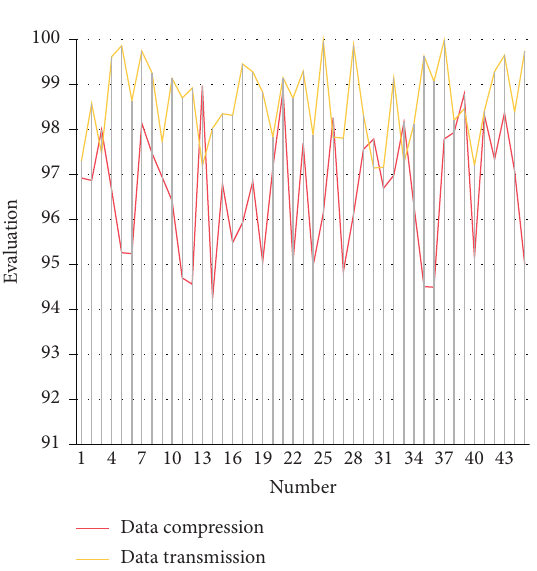
Figure 12: Statistical diagram of test